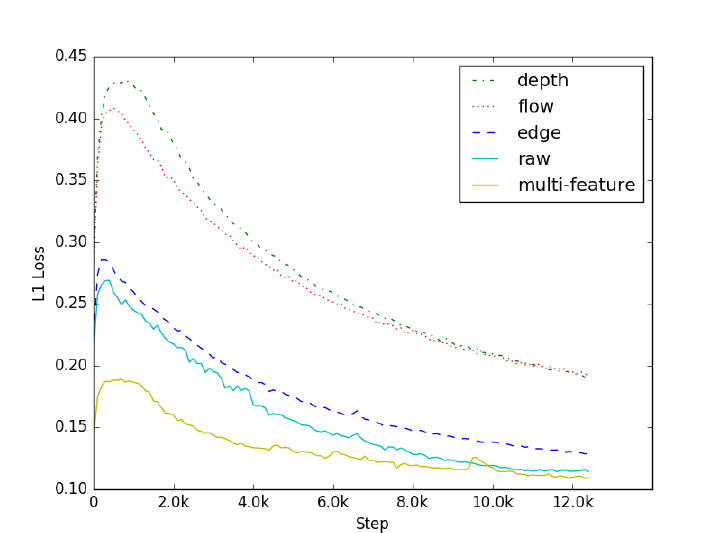
Figure 12. Comparison of L1 with different inputs.